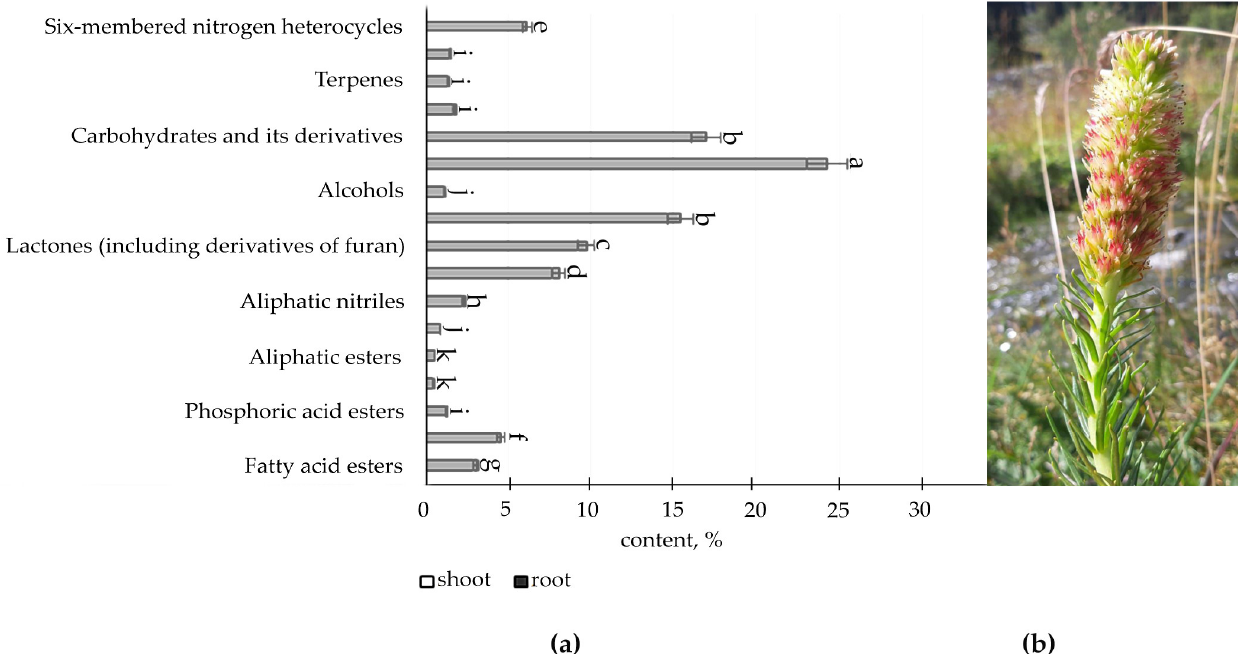
Figure 3. ( a ) Content of secondary metabolites classes in flowers of R. semenovii , %. Values presented are means (±SD). Different letters above the bars represent significant differences at p ≤ 0.05, n = 3 plants in each of 3 replicates for all treatments; ( b ) flower of R. semenovii .